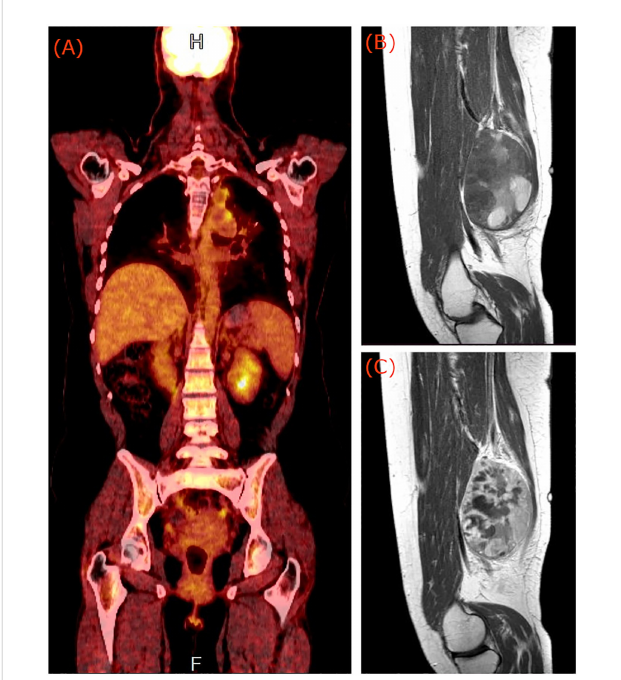
FIGURE 1 (A) PET/CT of the patient showing medium FDG uptake of the left hilar and mediastinum nodes. Pre (B) and post (C) contrast sagittal T1 weighted magnetic resonance images of the right thigh of the patient, showing a deep-seated lobulated mass, with cystic regions, bleeding elements and strong heterogeneous enhancement indicative of synovial